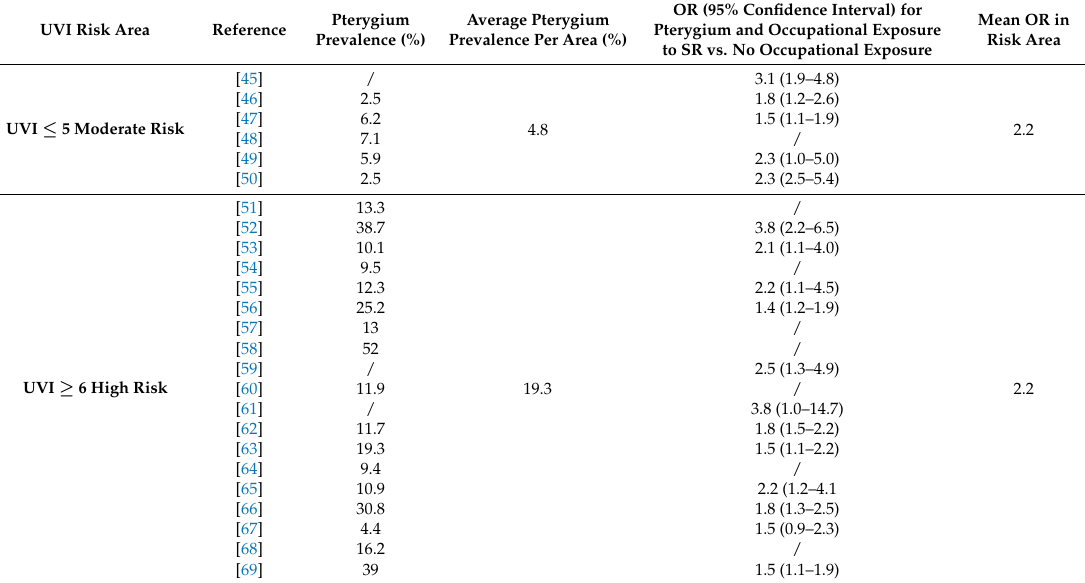
Table 4. Mean pterygium prevalence and mean odds ratios (ORs) calculated based on scientific studies on pterygium and outdoor work published in the period of 2008 to 2017 according to the UV risk areas: evaluation of the differences (adapted from Modenese and Gobba